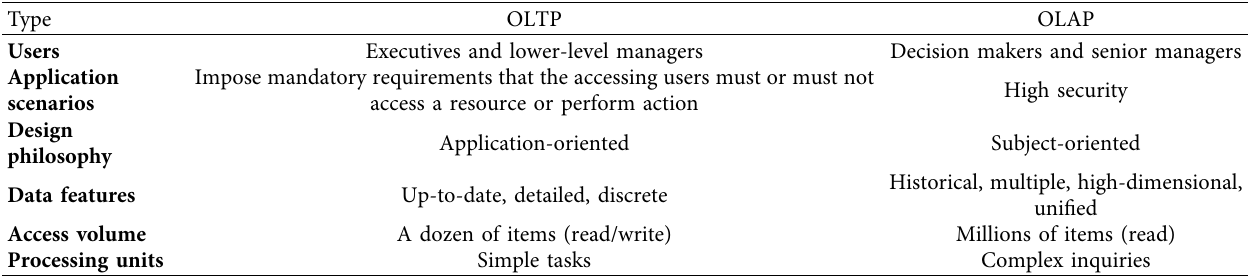
Table 2: OLTP and OLAP